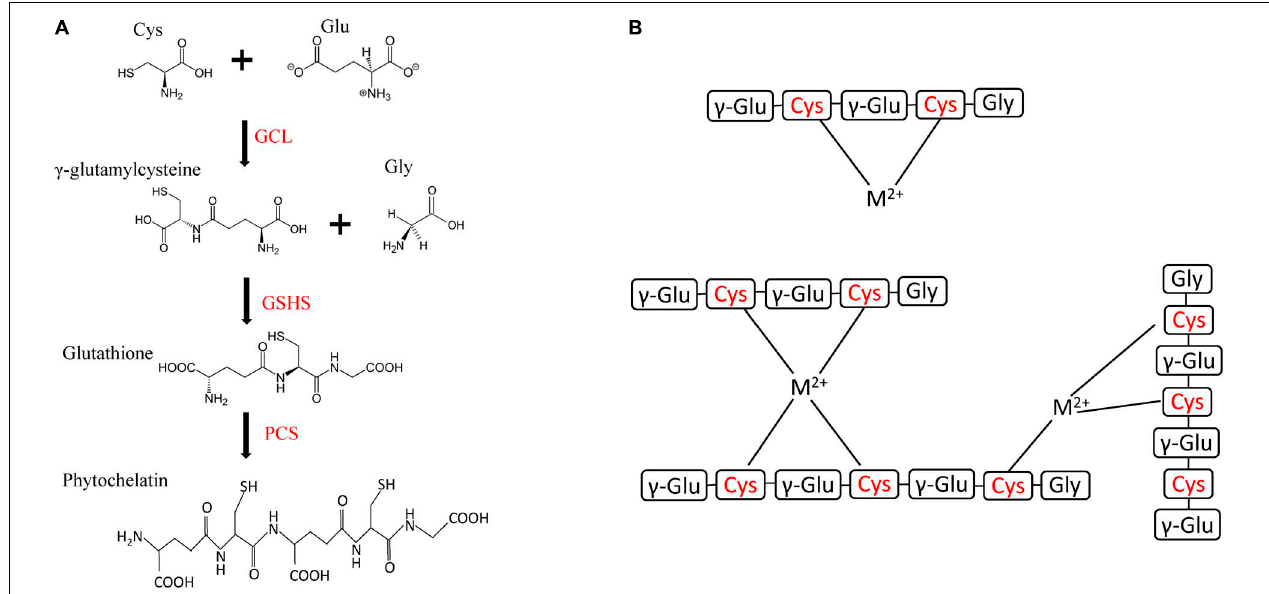
FIGURE 3 | Structure and biosynthetic pathways of glutathione (GSH) and phytochelatin (PC). Three-letter abbreviations correspond to amino acid codes. (A) The biosynthetic pathway of GSH and PC consists of two and three reactions, respectively. First, a cysteine unit binds to the carboxylic group of the side chain of glutamic acid residue to form γ -glutamylcysteine, and this reaction is catalyzed by glutamate–cysteine ligase (GCL), then γ -glutamylcysteine binds to a glycine residue to form glutathione, and glutathione synthetase (GSHS) catalyses this reaction. PC-synthase (PCS) might then bind two or more GSH units to form phytochelatins. (B) Example of PC–metal complexes for divalent cations. M 2 + denotes bivalent metal cations, whereas cysteine residues are indicated in